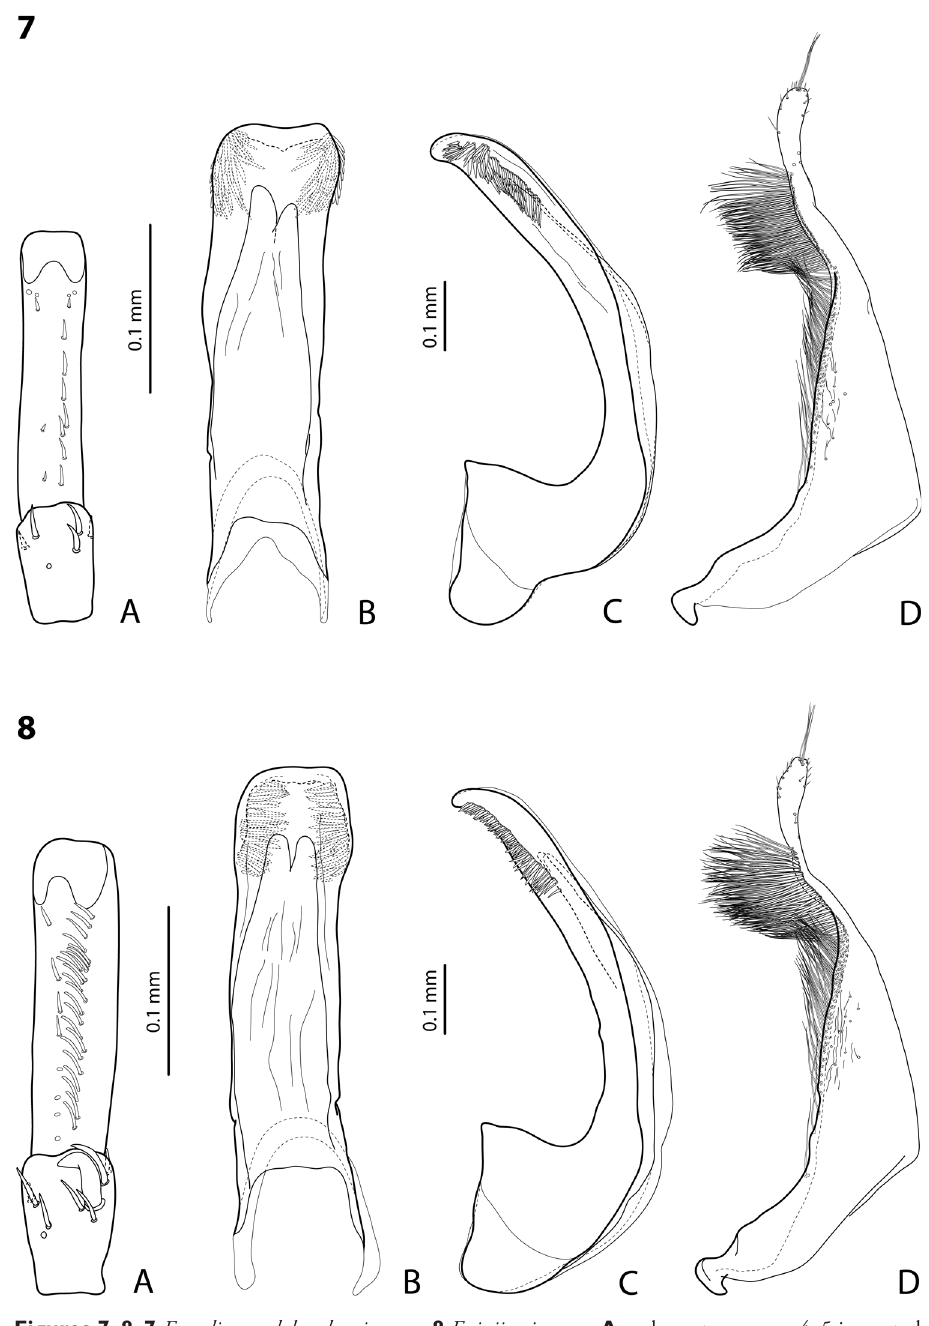
view B median lobe in ventral view C median lobe in lateral view D paramere in external